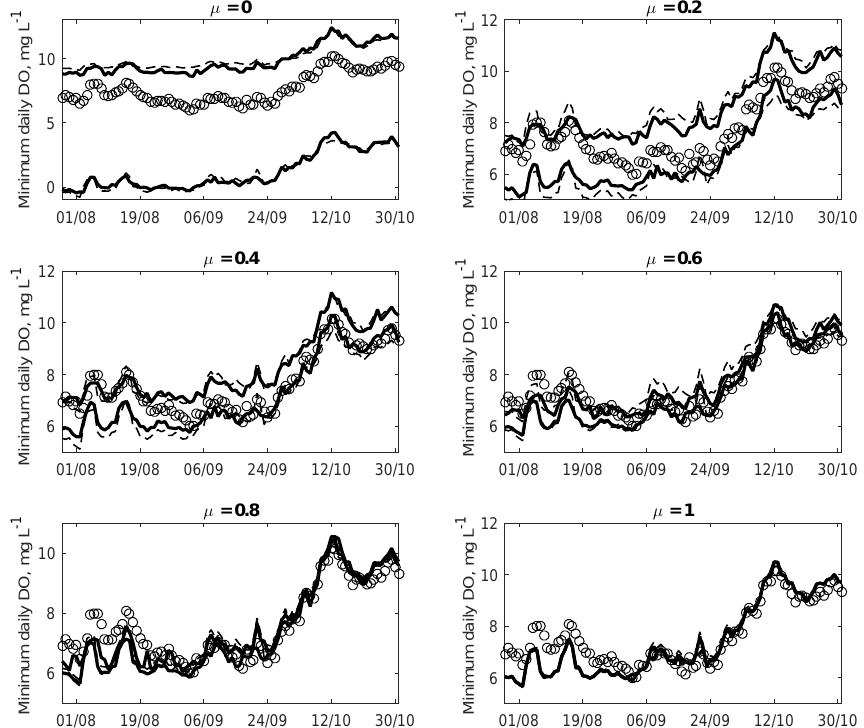
Figure 10. Comparison of predicted trends of the proposed (solid black line) and existing (dashed black line) methods shown for 2009 for each membership level. Observations are shown as black circles.